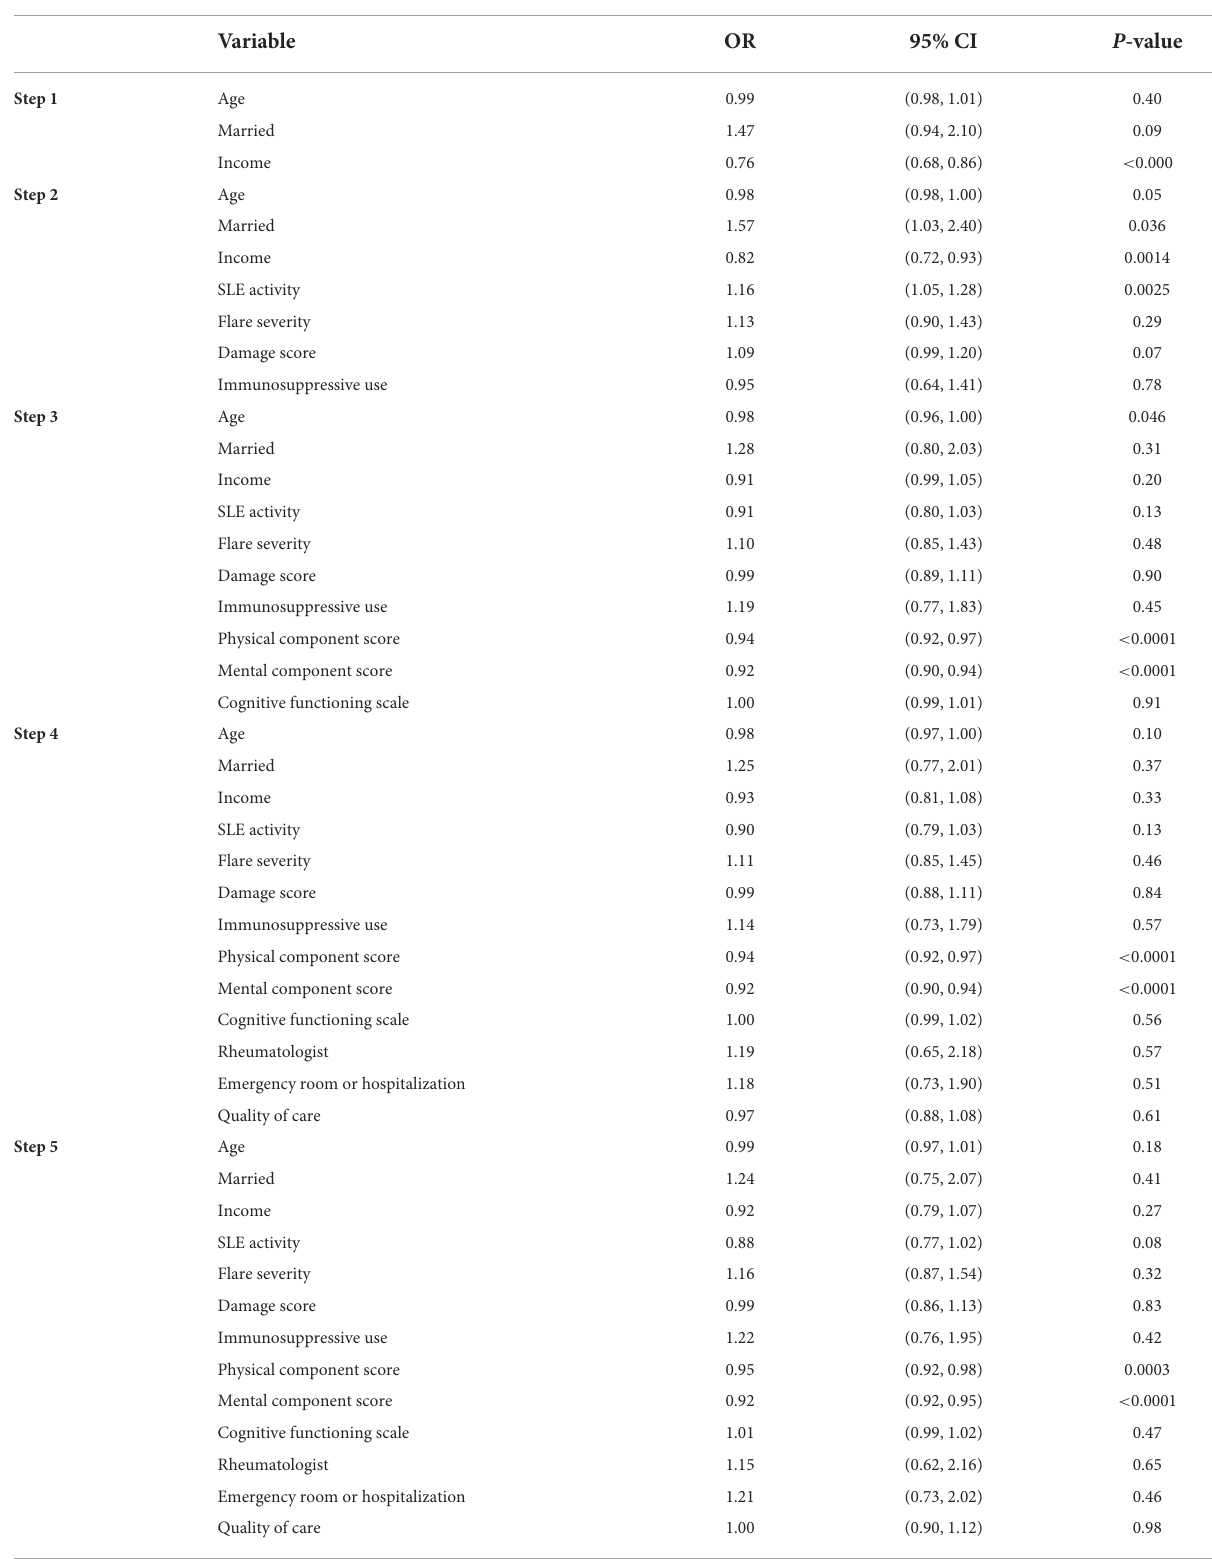
TABLE 4 Logistic regression models for high stress (PSS > 6) longitudinally (wave